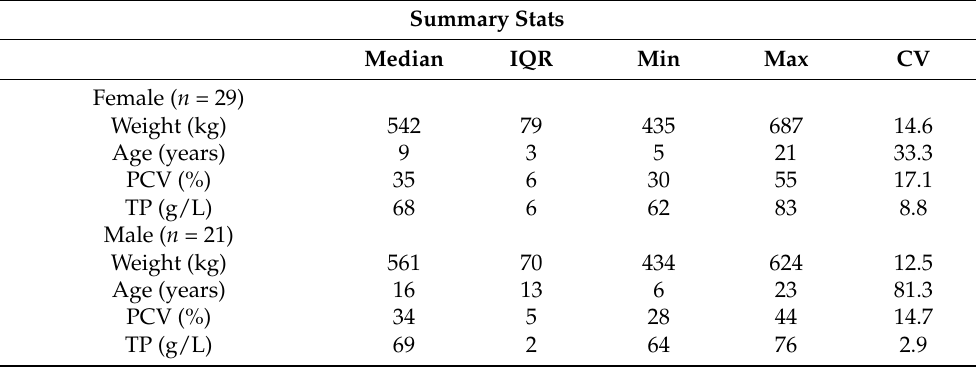
Table 1. Summary statistics of the age, weight, packed cell volume (PCV) and total protein (TP) for 50 horses.